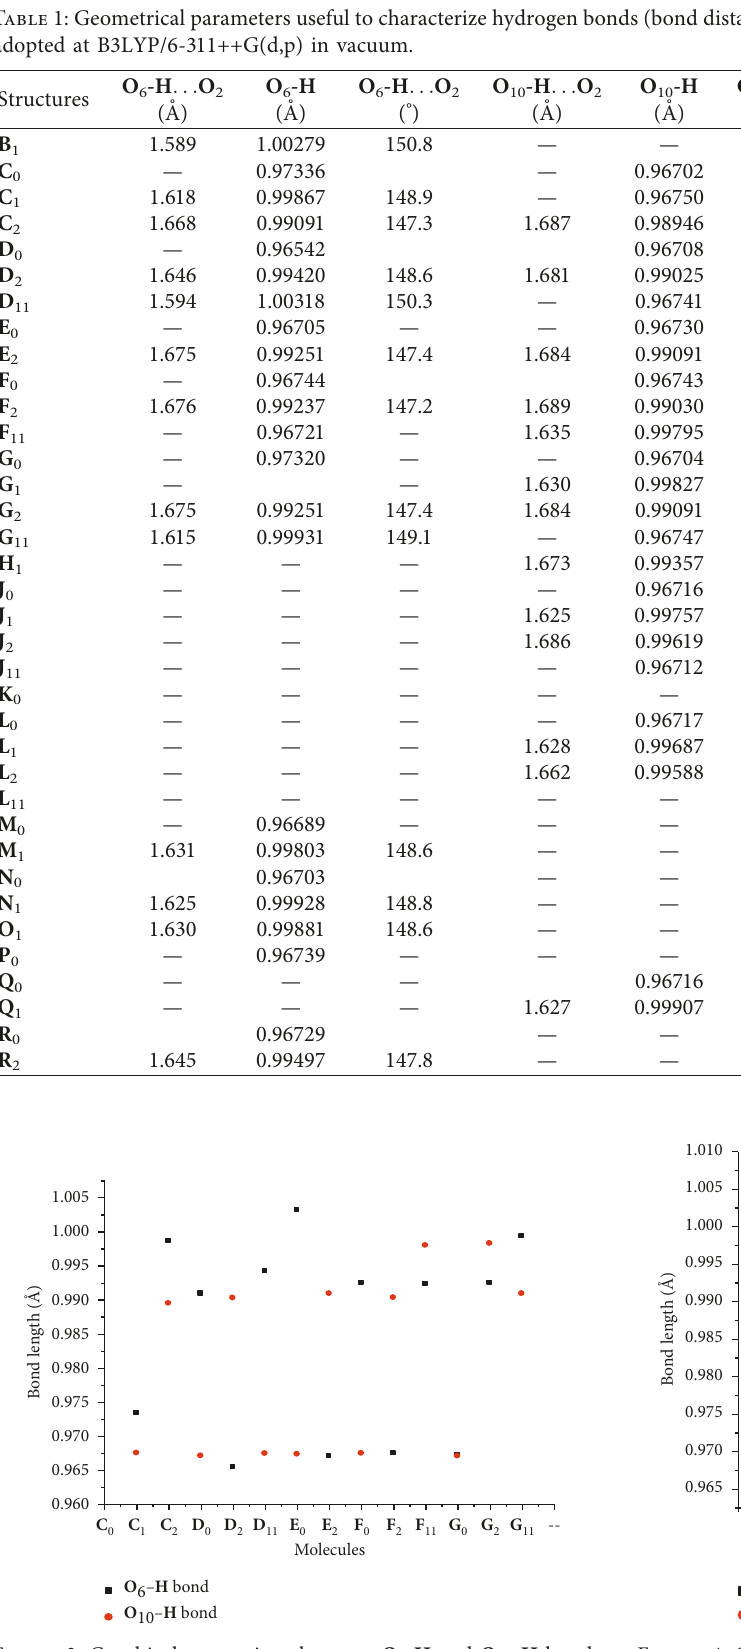
Figure 4: Graphical comparison between O 6 -H and O 10 -H bond distances at B3LYP/6-311++G(d,p) level in